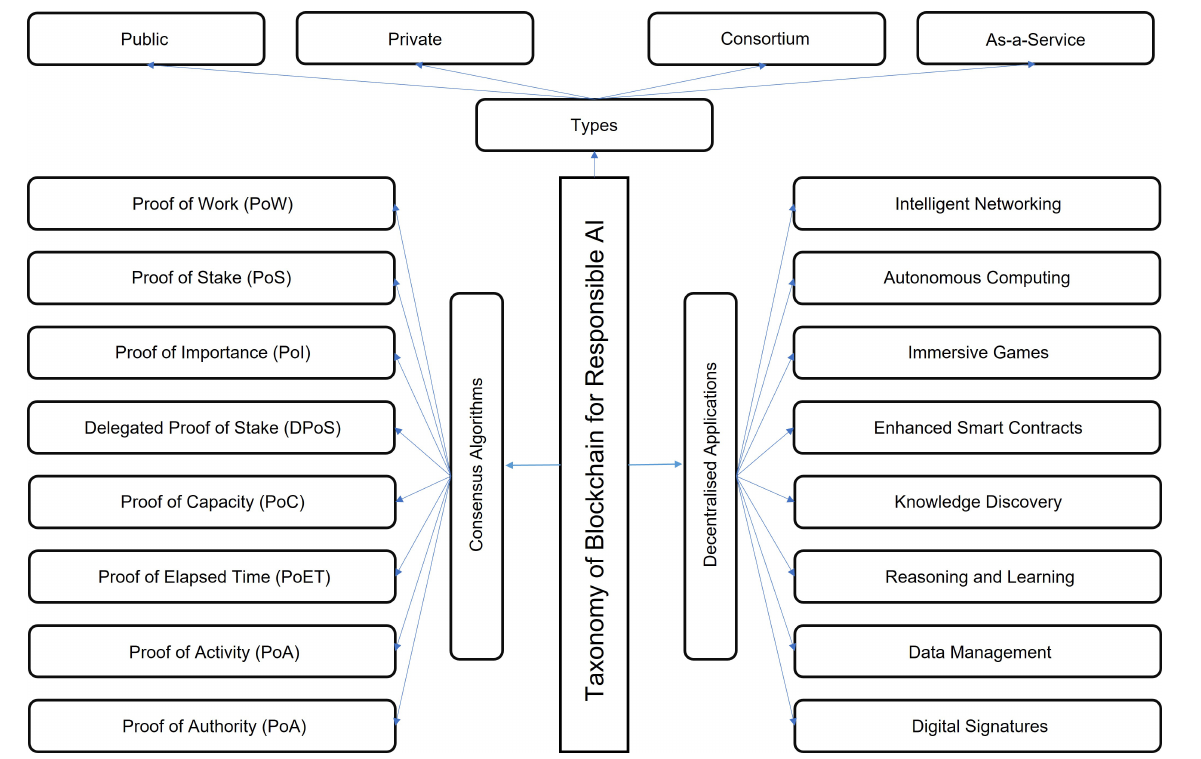
Figure 3. Taxonomy of blockchain for responsible